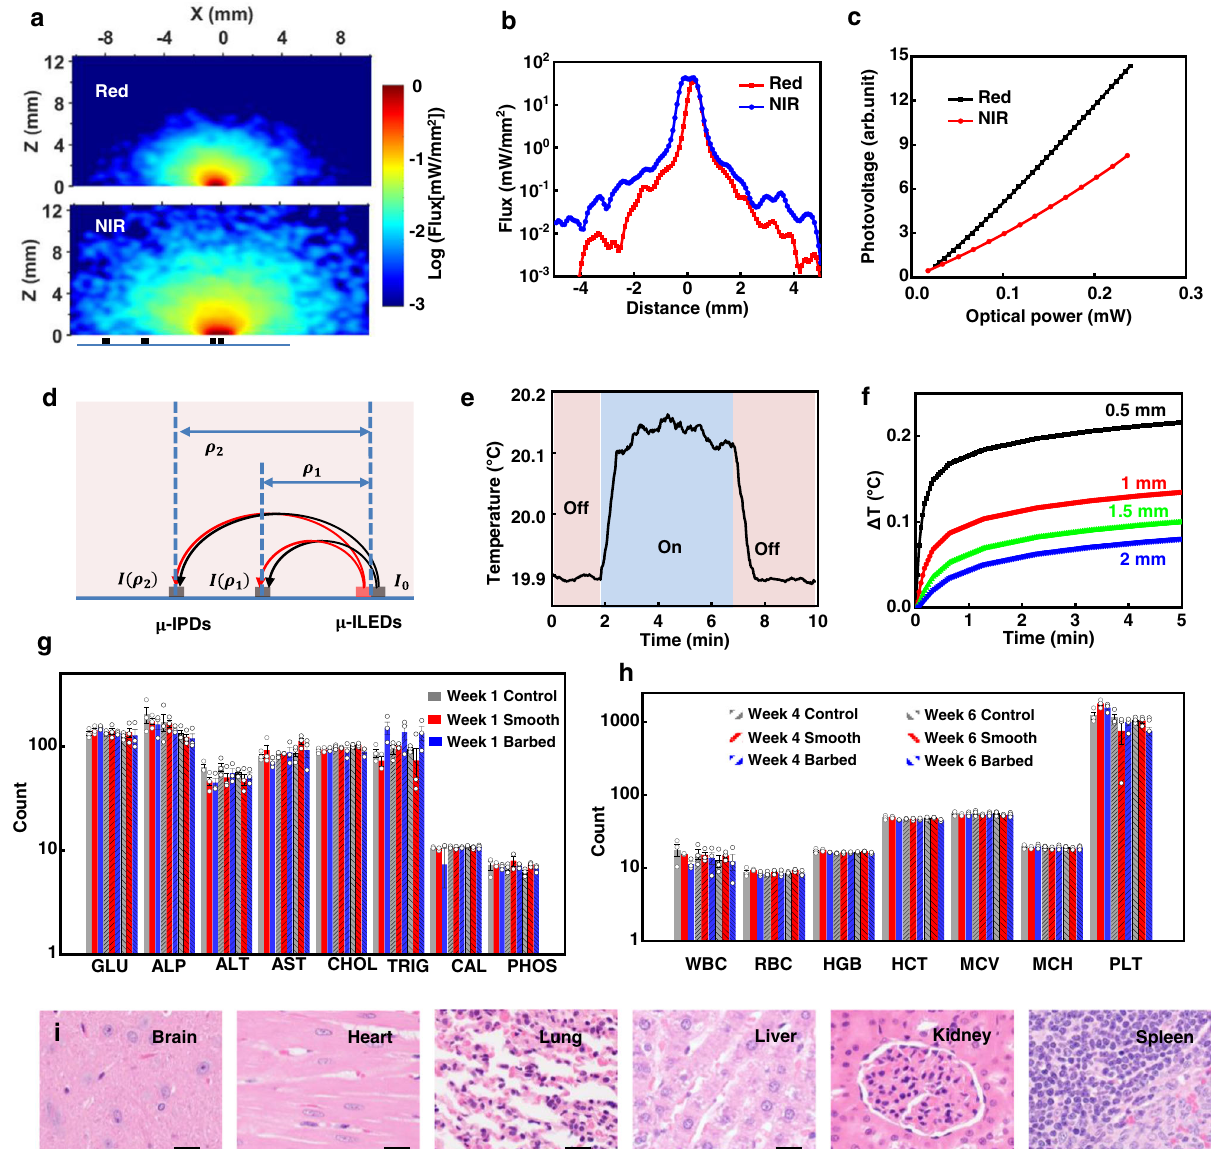
Fig. 2 Characterization of the NIRS probe. a Monte Carlo simulation results for the spatial distribution of the normalized fl ux intensity of red (top) and NIR (bottom) light emitted from the μ -ILEDs on the probe into muscle tissue. b Simulated fl ux distribution along the probe direction, with x -axis as de fi ned in a . c Measured photovoltage response of the μ -IPD as a function of illumination intensity. d Schematic illustration of the design parameters for the spatially resolved spectroscopic method with a pair of μ -IPDs and a pair of μ -ILEDs. e Measured temperature variations at regions near the μ -ILEDs during normal operation (50 Hz, 10% duty cycle of red and NIR μ -LEDs) for 5 min in porcine meat. f Finite Element Analysis (FEA) results for the change in temperature during normal operation, at different distances above the μ -ILEDs. g , h Measured results for g blood chemistry and h complete blood count of rats with sham surgery (control) and implanted NIRS probes (two groups, one with bioresorbable barbs, the other without bioresorbable barbs) for 1, 4, and 6 weeks, respectively. GLU glucose (mg/dL), ALP alkaline phosphatase (U/L), ALT alanine aminotransferase (U/L), AST aspartate transaminase (U/L), CHOL cholesterol (mg/dL), TRIG triglycerides (mg/dL), CAL calcium (mg/dL), PHOS phosphorus (mg/dL), WBC white blood cell (×1000/ μ L), RBC red blood cell (×1,000,000/ μ L), HGB blood hemoglobin level (g/dL), HCT hematocrit level (%), MCV mean corpuscular volume (fL), MCH mean corpuscular hemoglobin (pg), PLT platelet count in blood (×1000/ μ L). n = 3 independent samples. All data are shown as mean ± SEM. i Images of tissue sections of brain, heart, lung, liver, kidney, and spleen, 6-weeks post-implantation of a barbed NIRS probe. All tissue sections were stained with hematoxylin